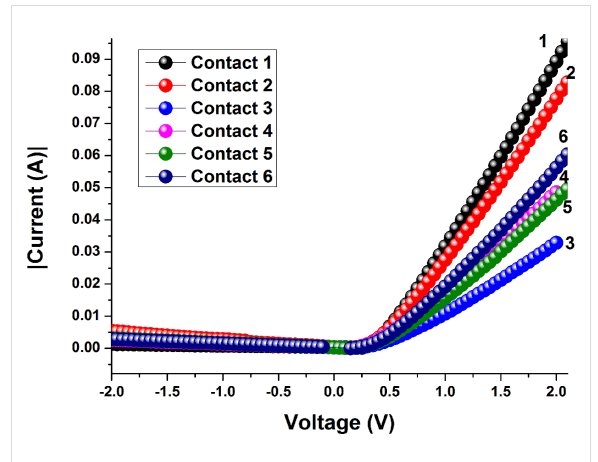
Figure 2: Current–voltage characteristics of the vertical graphene–4H- SiC device. The y -axis indicates the absolute values of current. Palla- dium contacts (1–6) are positioned at different places on the graphene surface